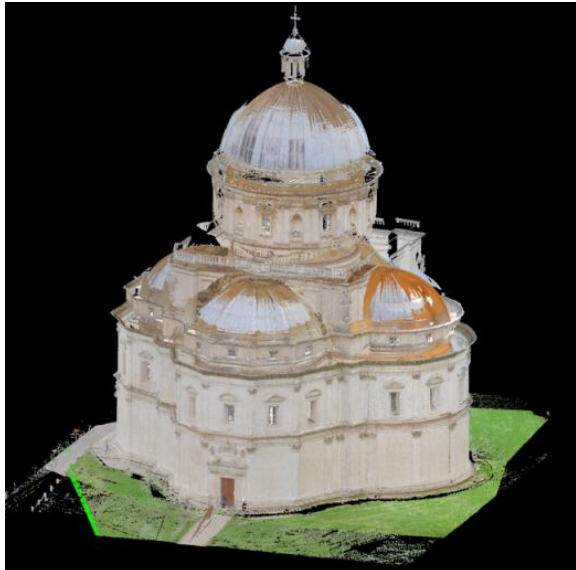
Figure 9. Point cloud assembled and coloured